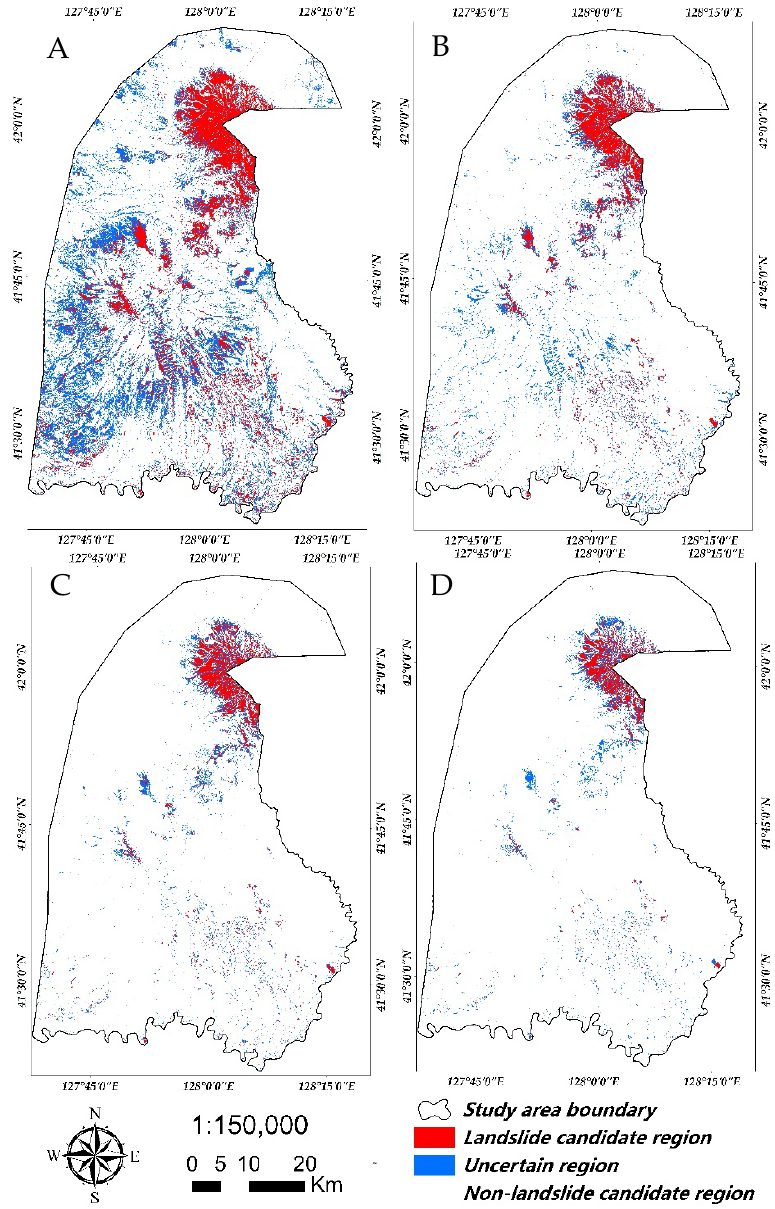
Figure 4. Thresholding test results. ( A ) T and ∆ T as 0.5 and 0.5; ( B ) T and ∆ T as 1 and 1; ( C ) T and ∆ T as 1.5 and 1.5; ( D ) T and ∆ T as 2 and 2.